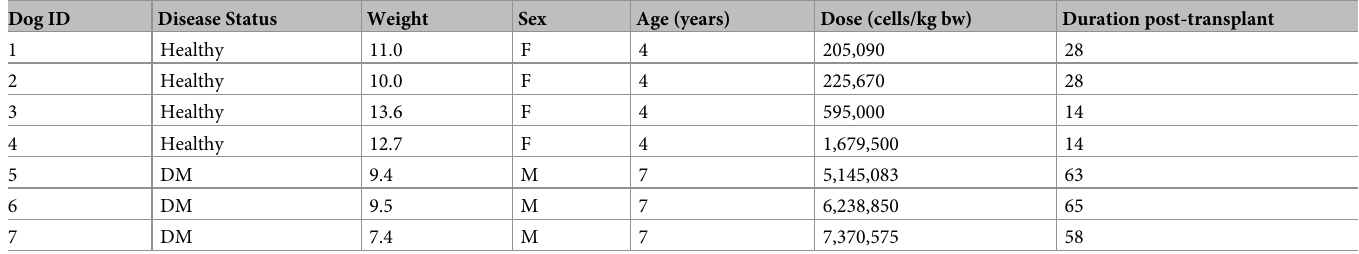
Table 3. Transplant